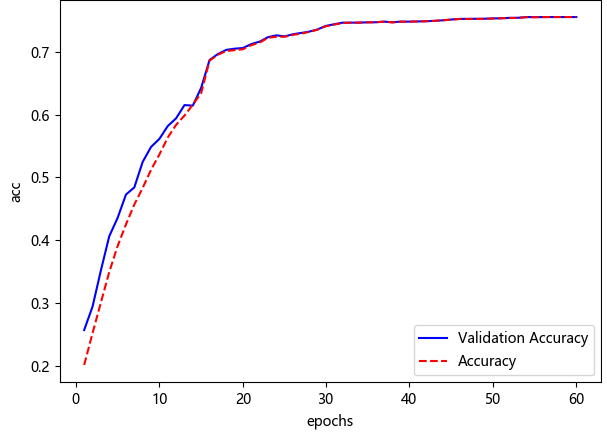
Figure 7. The accuracy curve of MCF-Net on CAER-S dataset.